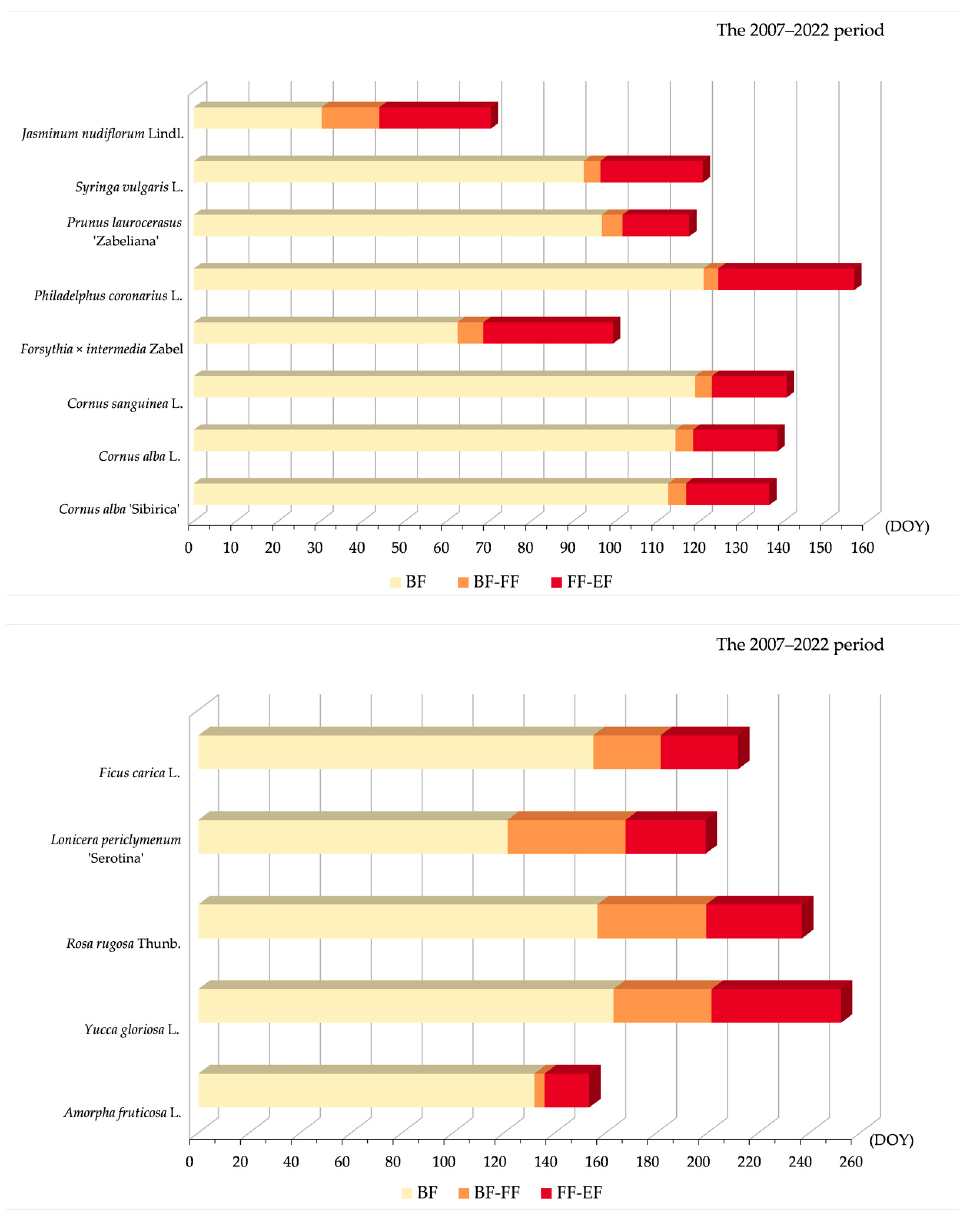
Figure 4. Phenological observations: periods and DOY for the beginning of flowering (BF), full flowering (FF), and the end of flowering (EF) for 13 woody taxa for the period 2007–2022. Linear trends for DOY determined by the Mann–Kendall test for the observed flowering phenophases for 13 taxa for the period 2007–2022 are shown in Figure 5 and Table S6.